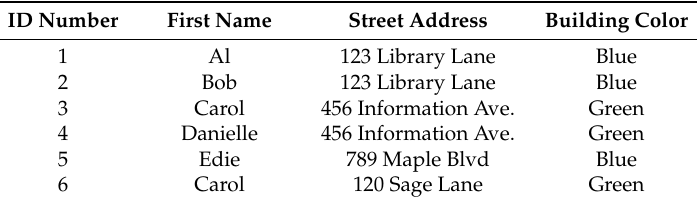
Table 1. Sample Relational